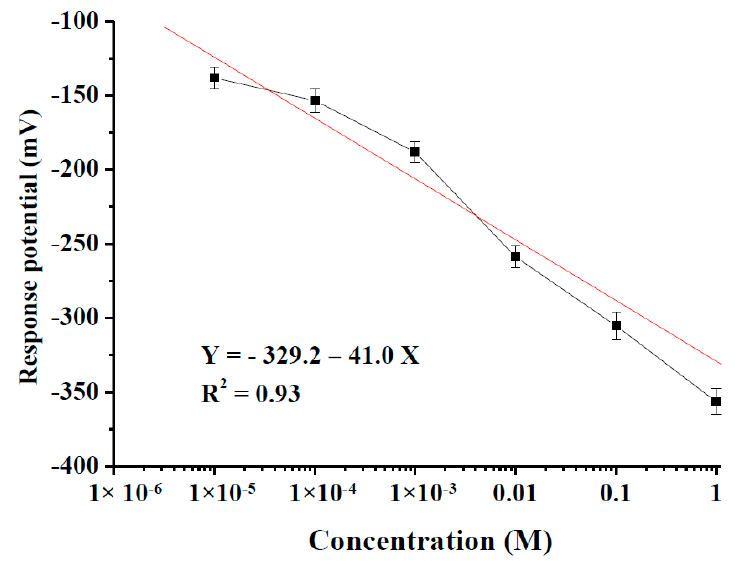
Figure 5. The curve of the response potential versus different chloride concentrations for the arrayed flexible RuO 2 /GO chloride sensor from 10 − 5 M to 1 M NaCl solutions at room temperature 25 °C. Table 1. The comparisons of the average sensitivity of the arrayed flexible RuO 2 /GO chloride sensor and other research on different chloride